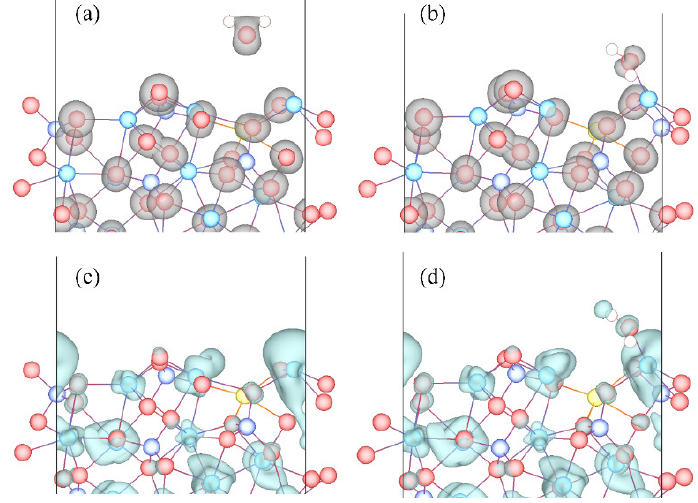
Figure 6. Decomposed charge density of the molecular adsorption on the β-C 2 S (011) surface: ( a ) ρ TVB before adsorption, ( b ) ρ TVB after adsorption, ( c ) ρ BCB before adsorption, and ( d ) ρ BCB after adsorption. Note: isosurface level was 0.05 eV for ρ TVB illustration and 0.02 eV for ρ BCB illustration.